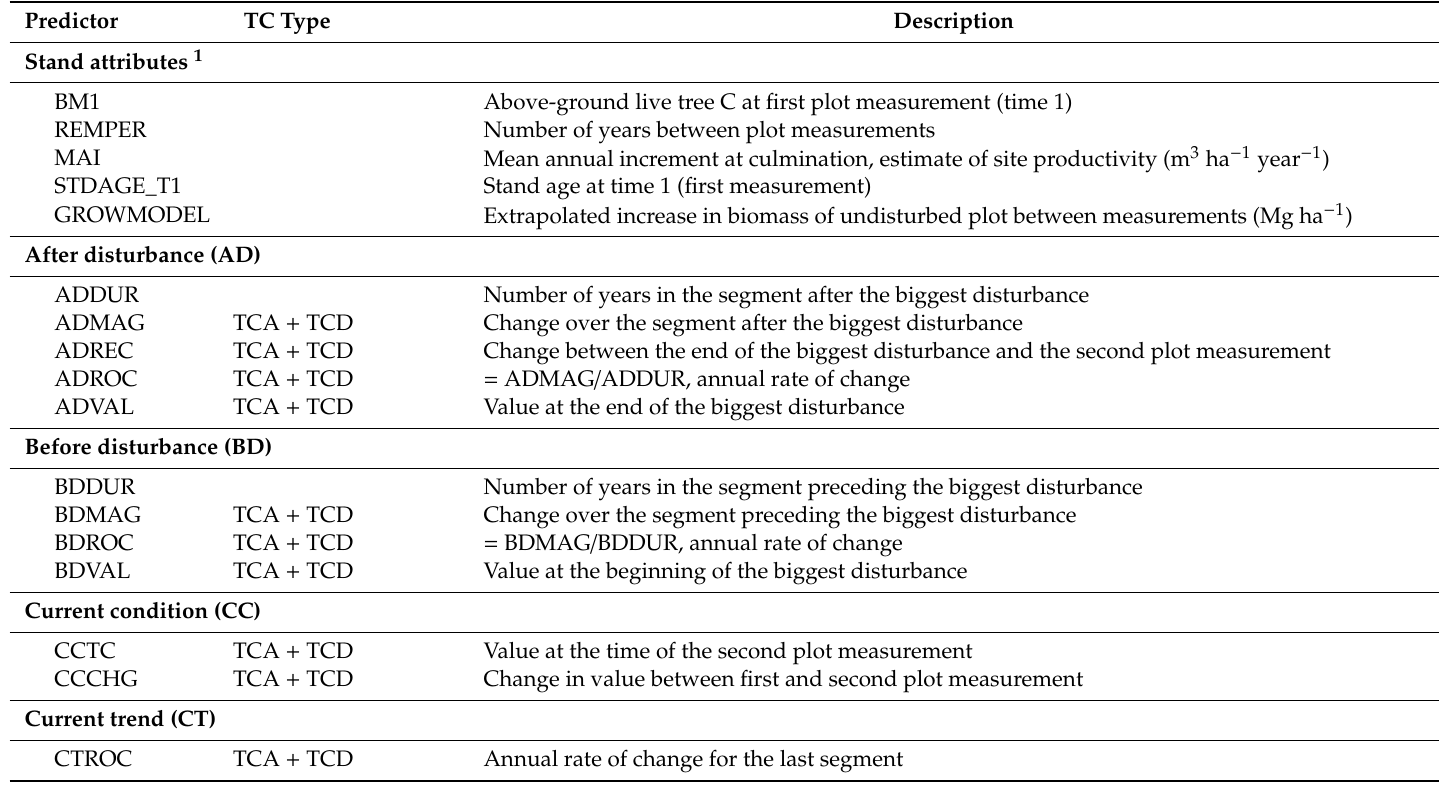
Table 1. Plot- and Landsat-based predictor variables used to estimate change in forest C, using tassel cap angle (TCA) and distance (TCD), identified elsewhere with either “_a” or